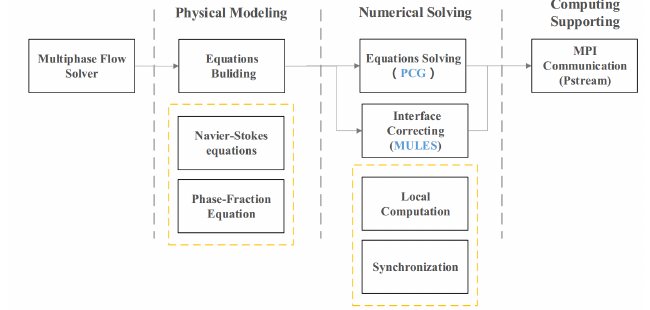
Figure 1. The framework of Multiphase Flow